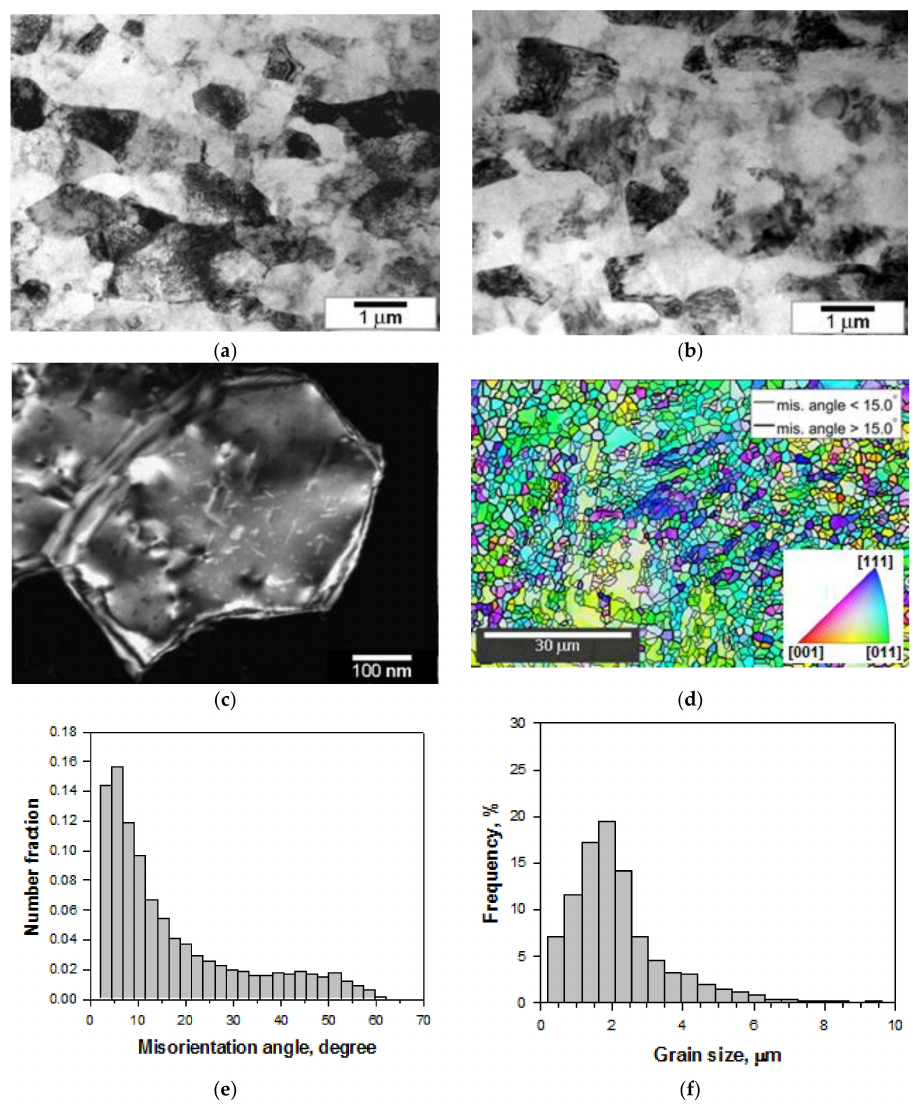
Figure 2. Al 6101 alloy after ECAP-C and AA at 170 ◦ C. ( a , c ) TEM images in the longitudinal section; ( b ) TEM image in the cross section; ( d ) EBSD map, cross section; ( e ) misorientation distributions, obtained from the cross section; ( f ) grain size distributions, obtained from the cross